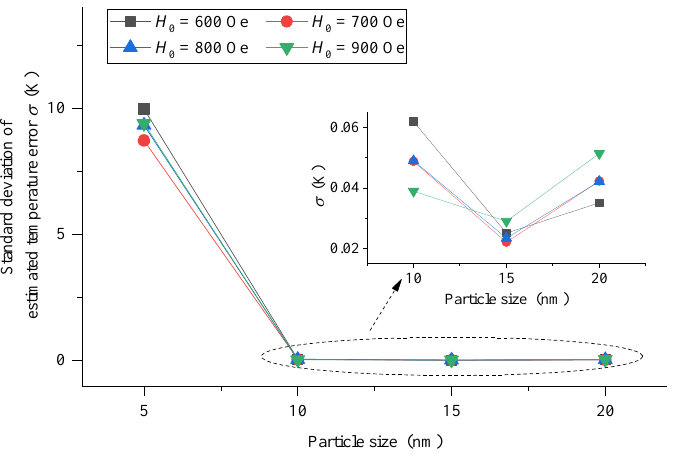
Figure 6. The standard deviation of the estimated measurement error of each temperature point in the whole measured temperature range using MNPs with particle size of 5 nm, 10 nm, 15 nm and 20 nm when H 0 = 600 Oe, 700 Oe, 800 Oe and 900 Oe, respectively. Furthermore, the relationship between the standard deviation and the amplitude H 0 of the triangular wave magnetic field is given, as shown in Figure 7. The temperature measurement performance of 5 nm MNPs is the worst. The standard deviation is not only very large (several K, or even greater), but also varies irregularly with the increase in amplitude H 0 . Therefore, 5 nm MNPs are not suitable for the DC thermometry model. On the contrary, when MNPs of 10 nm, 15 nm and 20 nm are used, the standard deviation obtained basically shows a trend of becoming better with the increasing amplitude H 0 . In addition, the larger the particle size of MNPs is, the smaller the requirement of amplitude H 0 is, and an excellent temperature measurement performance can be obtained in the triangular wave excitation magnetic field with smaller amplitude. For example, for 10 nm MNPs, when the amplitude H 0 is less than 200 Oe, the standard deviation is greater than 2 K, and the temperature measurement performance is not good. While when the amplitude H 0 is greater than 200 Oe, the standard deviation will be reduced to less than 1 K; when the amplitude H 0 is greater than 450 Oe, the standard deviation will be further reduced to less than 0.1 K. For 15 nm MNPs, the standard deviation is always less than 1 K; when the amplitude H 0 is greater than 150 Oe, the standard deviation will be further reduced to less than 0.1 K. For larger MNPs of 20 nm, the standard deviation is always within 0.1 K, and the dependence on amplitude H 0 is not obvious, and excellent temperature measurement performance can be obtained in the range of the studied excitation magnetic field amplitude.